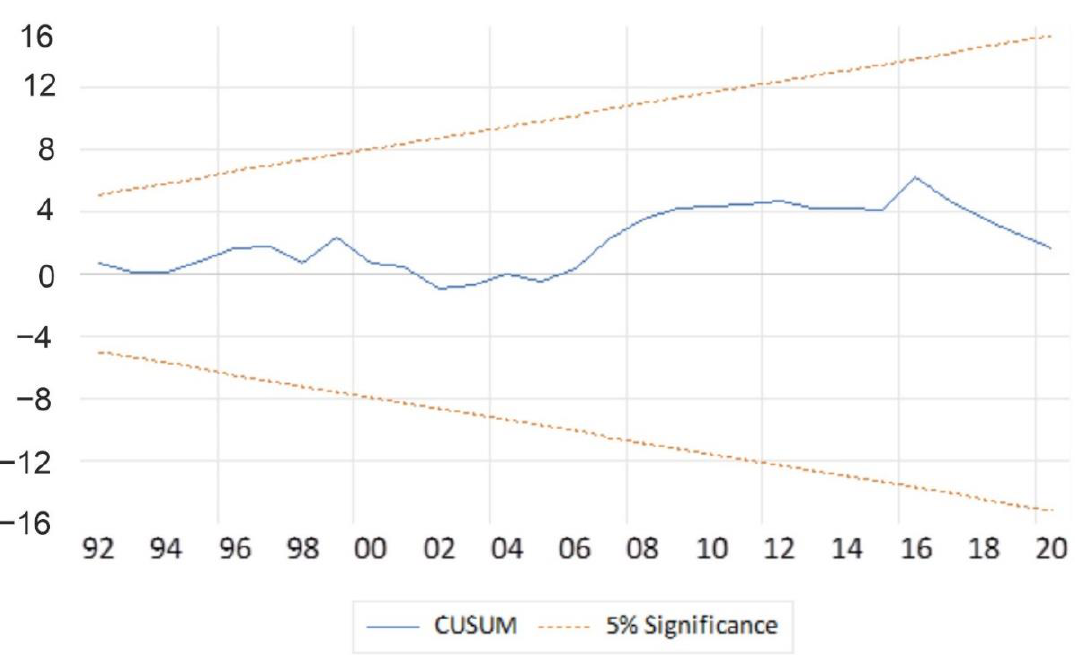
Figure 4. Stability tests (Cusum test). Source: Authors’ computations (2022).